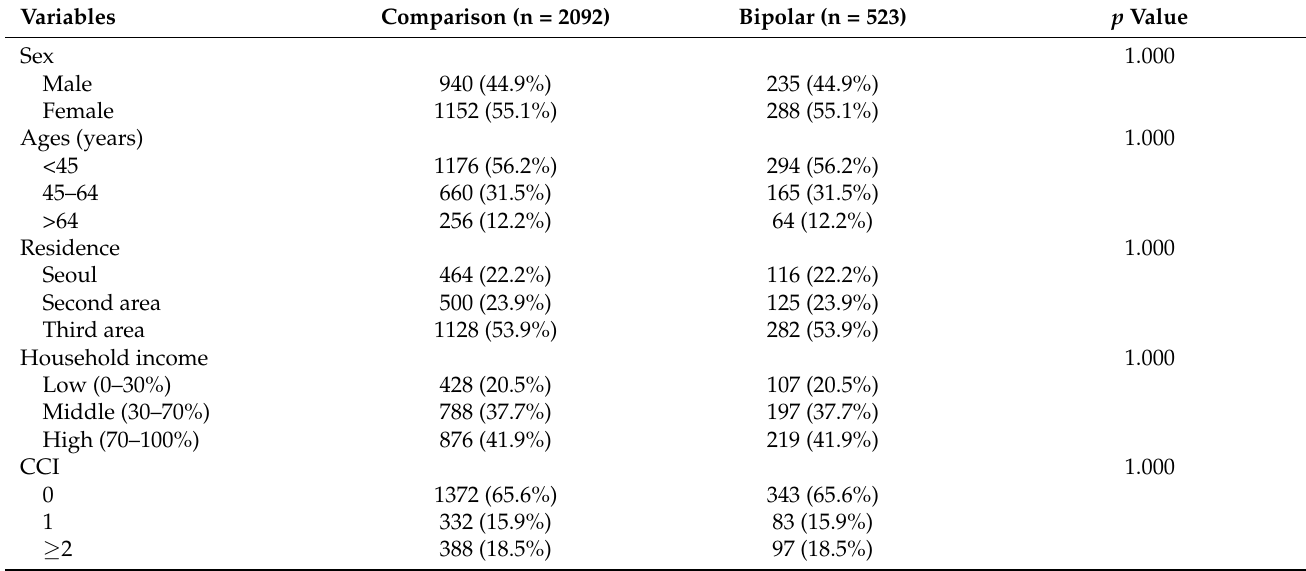
Table 4. Characteristics of the enrolled participants: comparison vs. bipolar group.